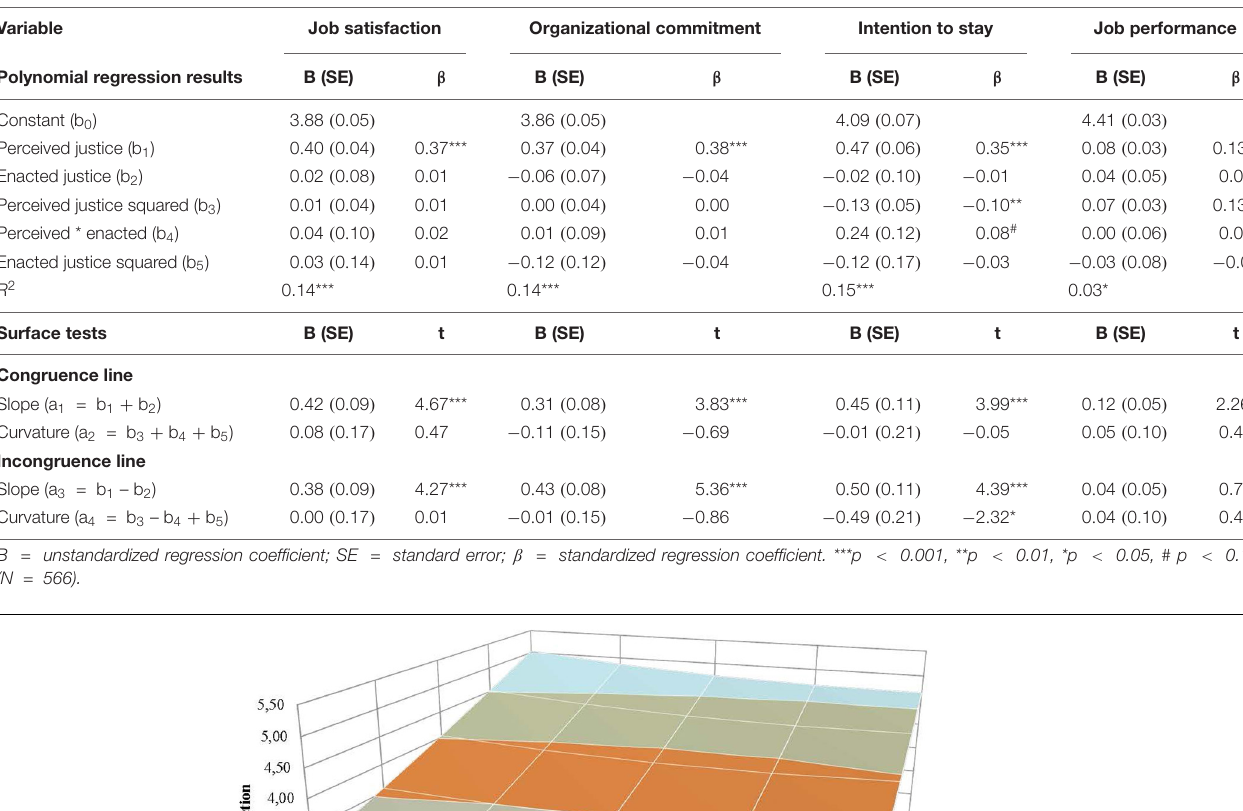
justice related to higher levels of employee job satisfaction.